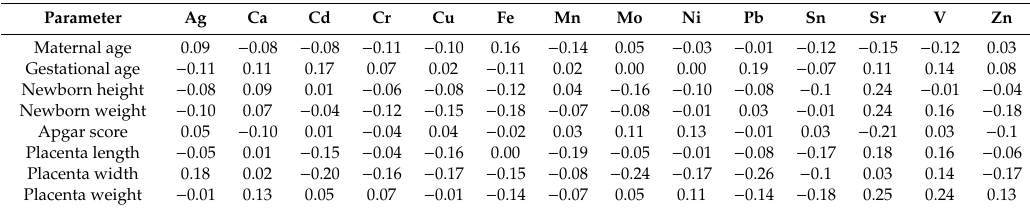
Table 10. Pearson’s coe ffi cients for correlations between biological parameters of the mother, newborn,